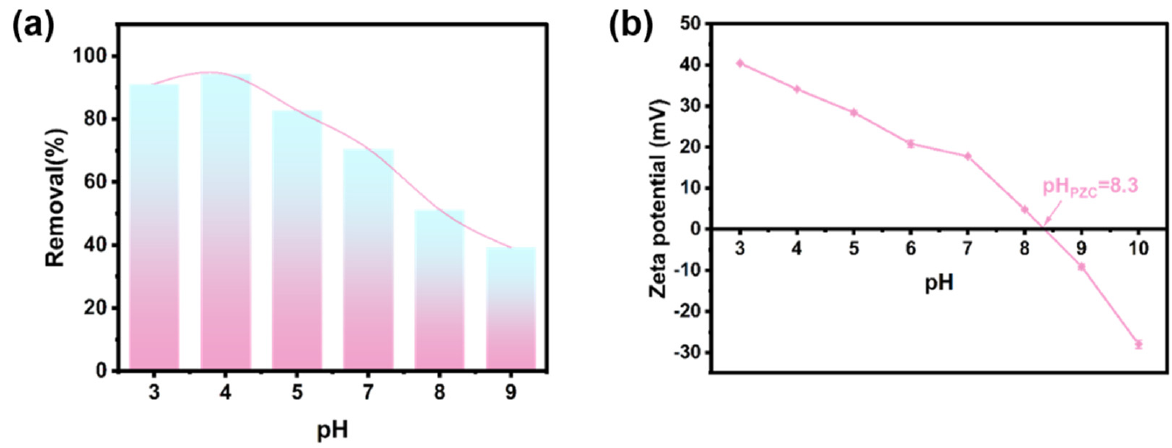
Figure 8. ( a ) Effect of pH on SMX removal. ( b ) Zeta-potential of bio − C − 900.